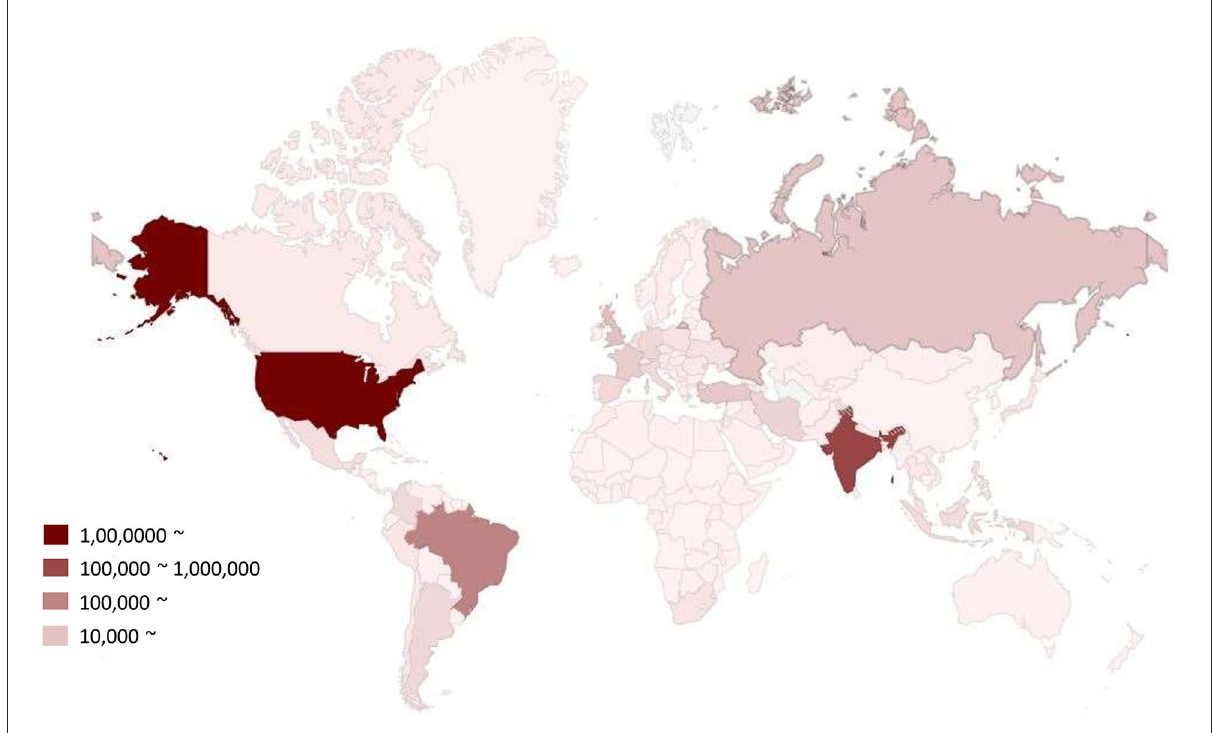
FIGURE1 COVID-19 outbreak all over the world. Different color indicated number of infected